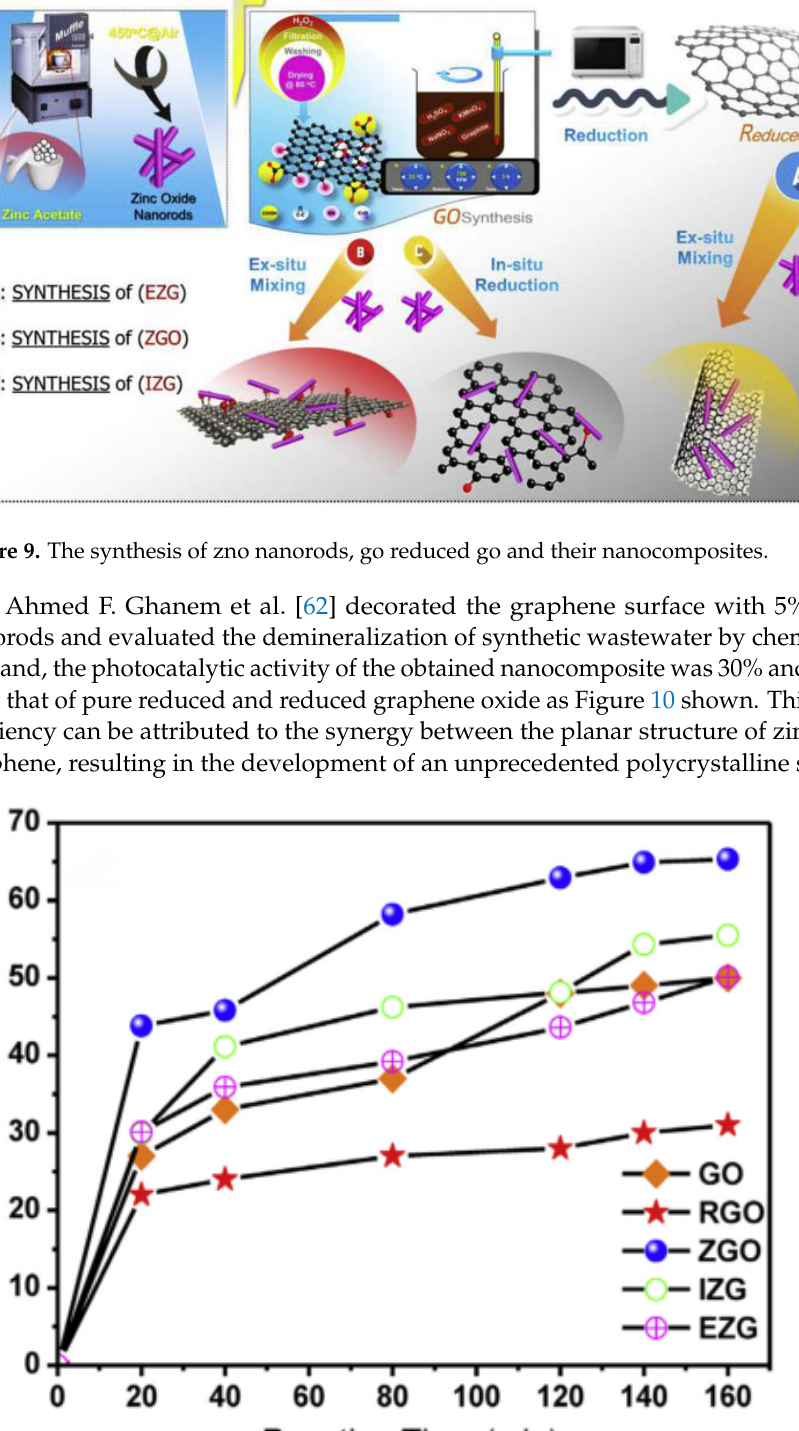
Figure 10. Demineralization of synthetic wastewater by different composite